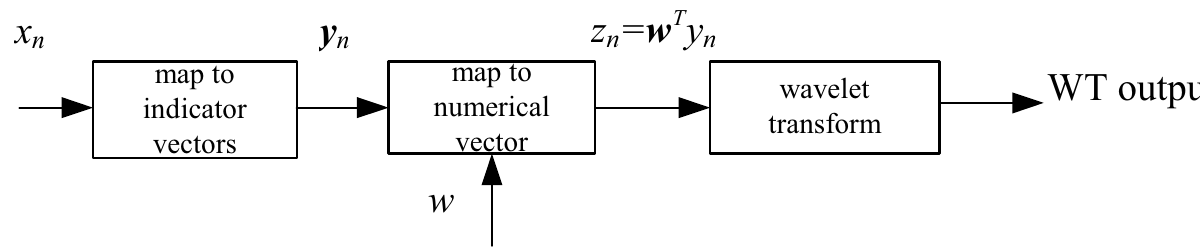
Figure 2 WT analysis of symbolic sequence based on fixed symbol-to-number